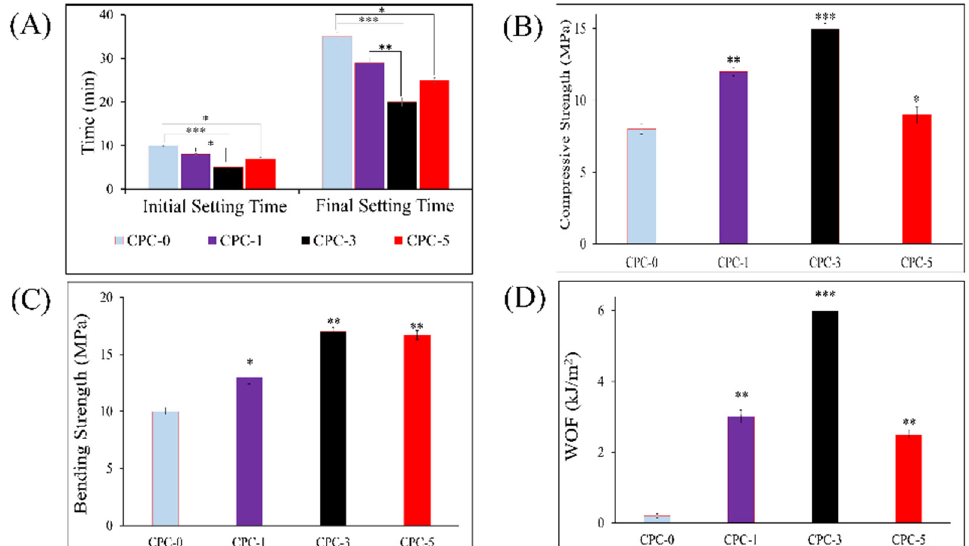
Figure 4. ( A ) The setting times of the different samples, ( B ) compressive strength, ( C ) bending strength, and ( D ) work-of-fracture values. (***, **, and * show significant differences between each group and the control sample (CPC-0) at p < 0.001, p < 0.01, and p < 0.05, respectively) .